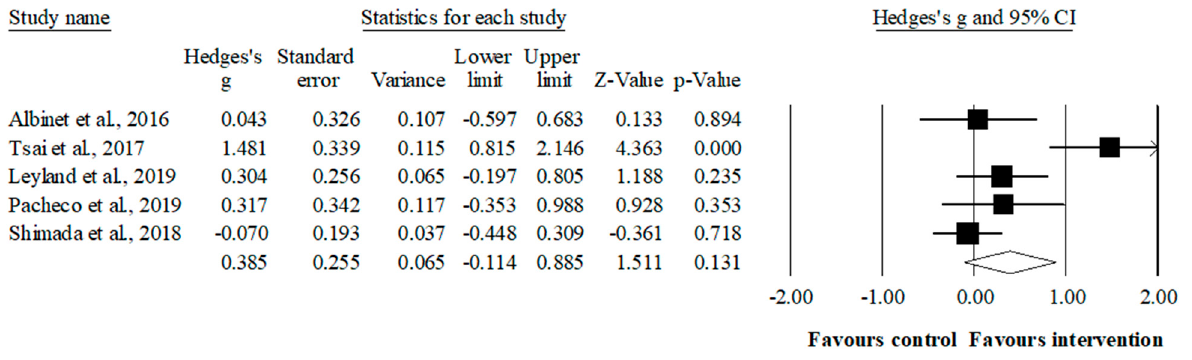
Figure 4. Forest plot of effects on cognitive flexibility. Values shown are effect sizes (Hedges’s g) with 95% confidence intervals. The size of the plotted squares reflects the statistical weight of the study [44,49–51,88].